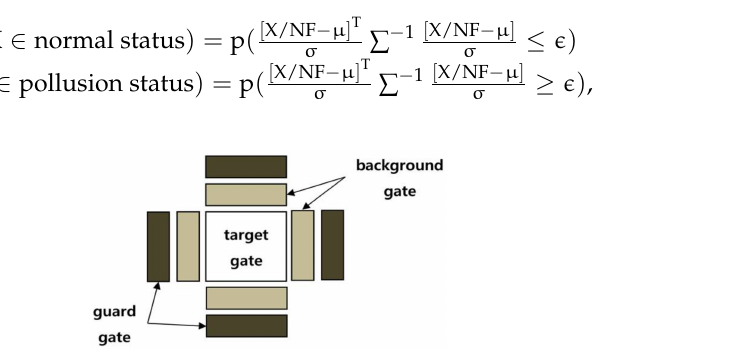
Figure 8. Shape of background gates and guard gates. There are four gates for each direction: up, down, left, and right side around target. Both background gate and guard gate are 1/4 size of target gate.